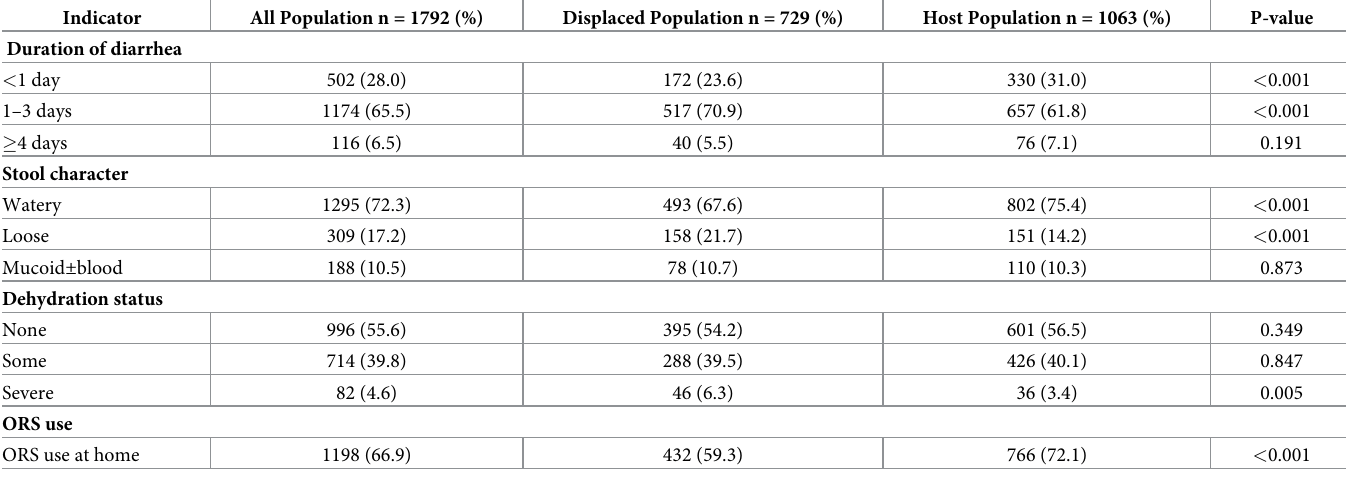
Table 2. Duration of diarrhea, stool character, dehydration status, and ORS use at home before attending DTCs � , April-December 2018, Cox’s Bazar, Bangladesh.